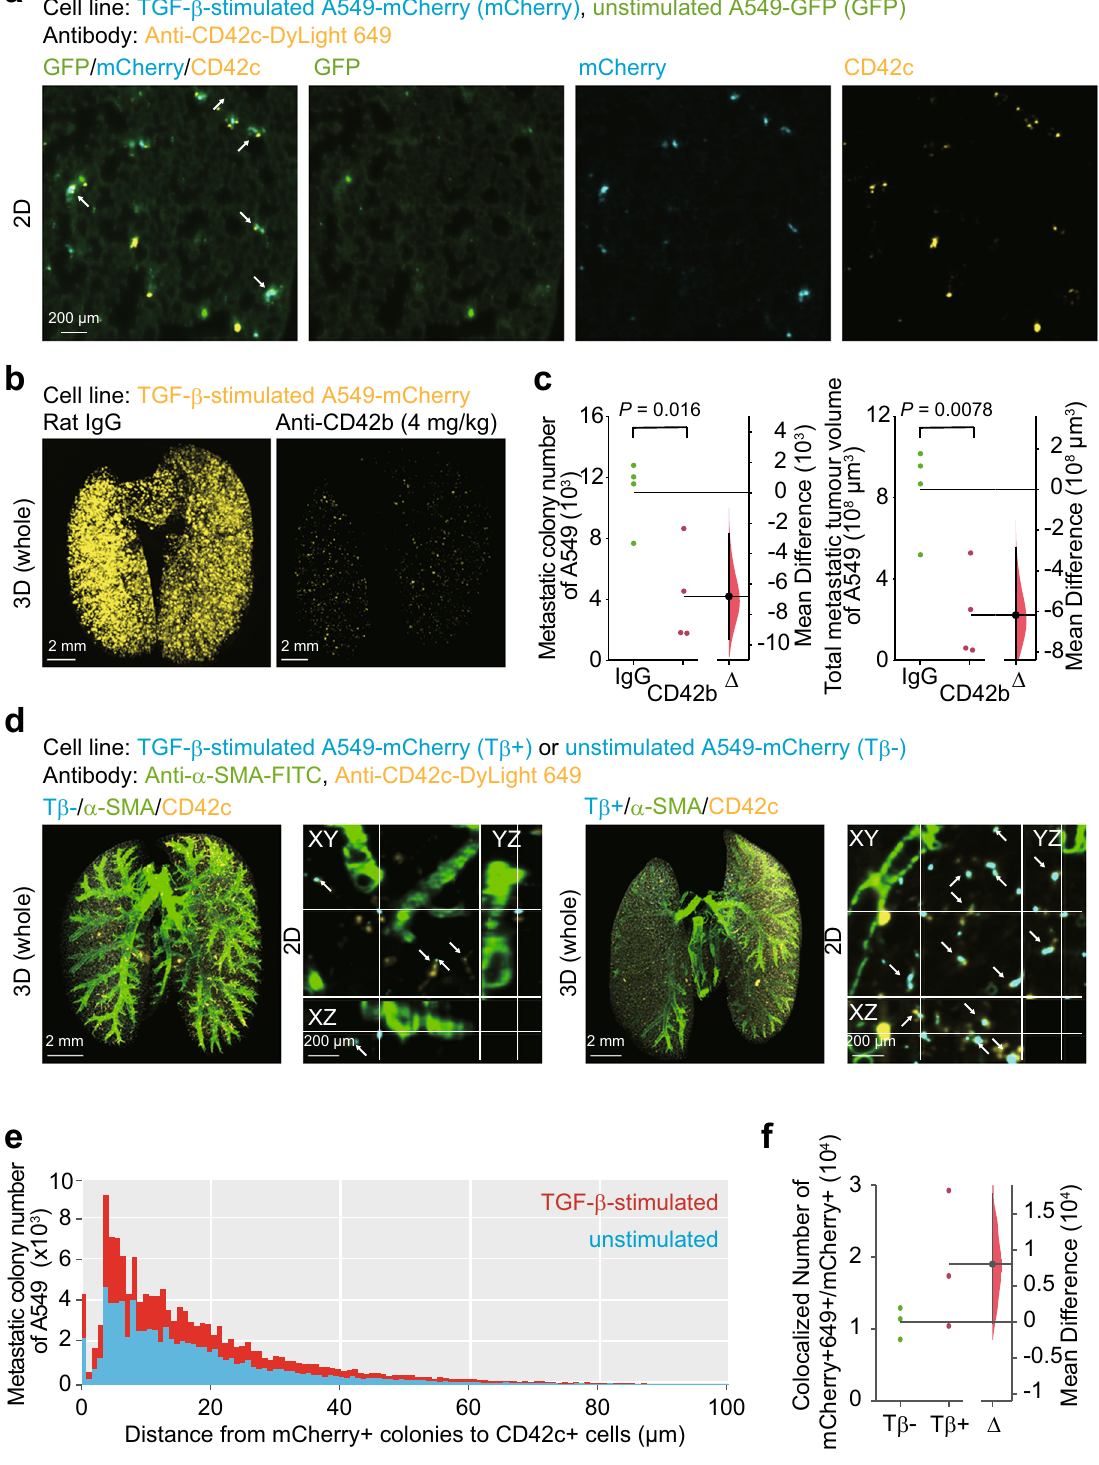
cancer cells (arrows in Fig. 6d). The distribution patterns of both cells are displayed in Fig. 6e. The number of metastatic colonies distributed within 10 μ m from platelets was approximately twice as many in mice bearing TGF- β -stimulated cancer cells as in mice bearing unstimulated cancer cells (Fig. 6f). Overall, these results may suggest that colonization of cancer cells is accelerated by the accumulation of platelets induced by TGF- β -stimulated cancer cells. COMMUNICATIONS BIOLOGY| (2021) 4:294